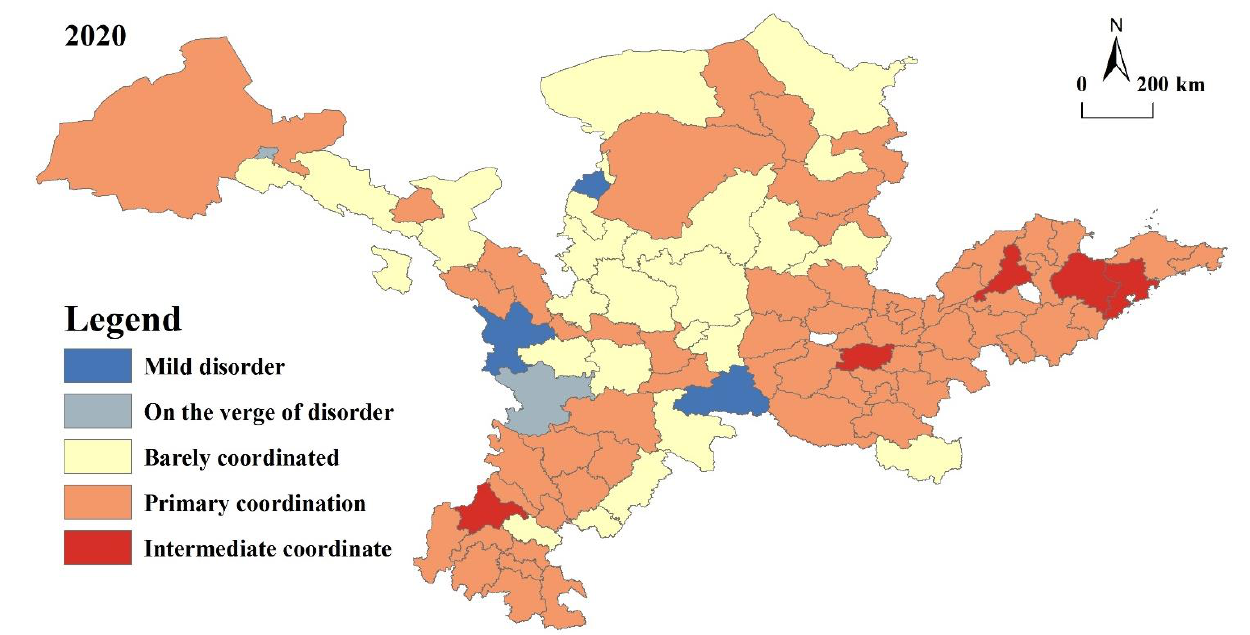
Figure 4. Distribution of types of URD coupling and coordination.